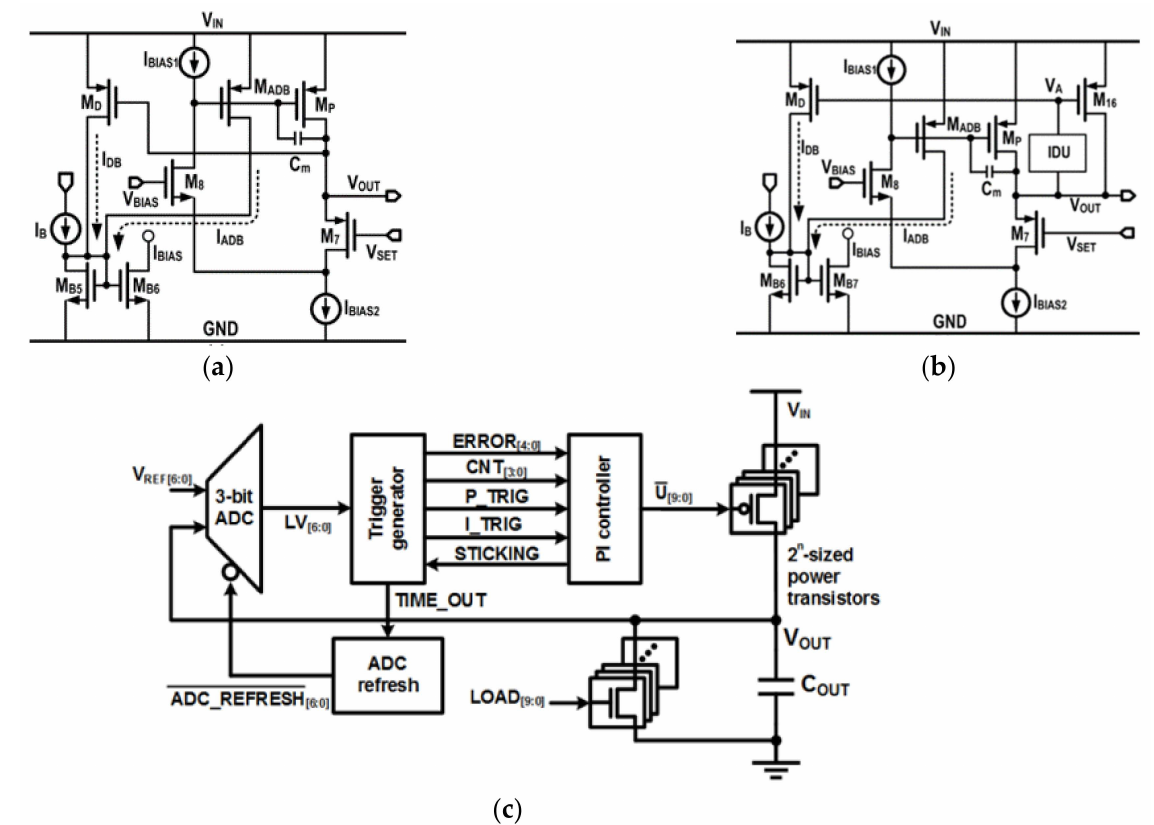
Figure 8. ( a ) Proposed structure of LDO 1 [53]; ( b ) proposed structure of LDO 2 [53]; and ( c ) LDO architecture with the proposed event-driven PI control systems [54]. Copyright 2022